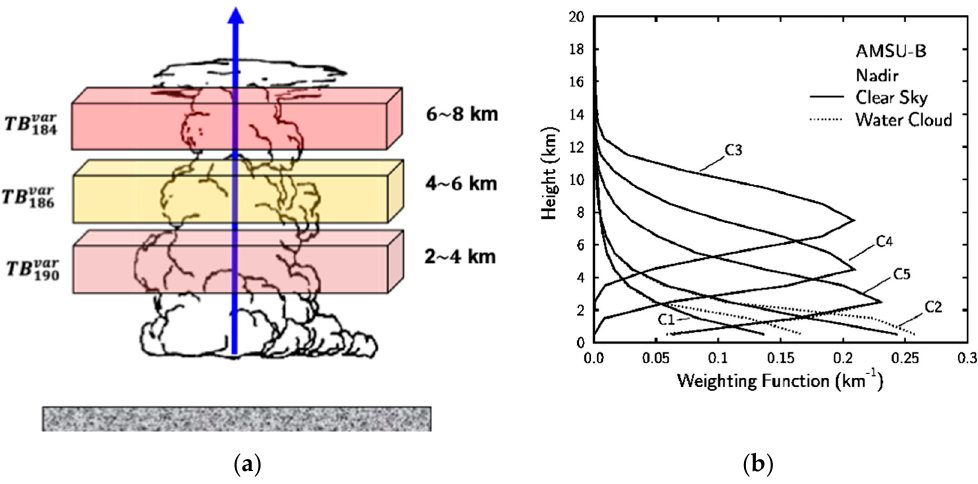
Figure 2. Conceptual scheme of the MicroWave Cloud Classification (MWCC) algorithm. ( a ) Artist image describing the impact ( TB var ) of convection development on each water vapor channel as a function of the height of the peak of the weighting functions; ( b ) channel weighting functions.